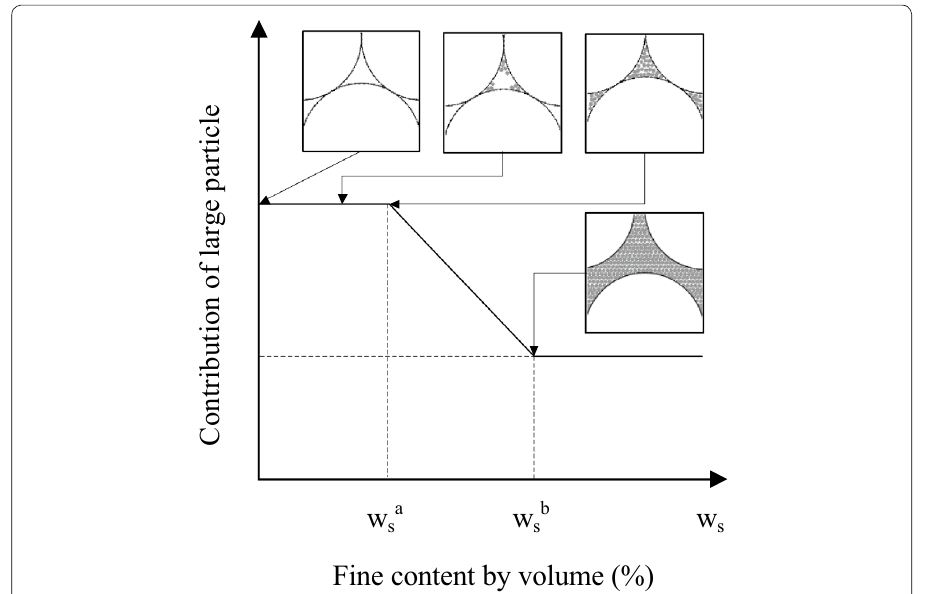
Fig. 2 The theoritical variation of contribution of large particle to shear strength with varying fine